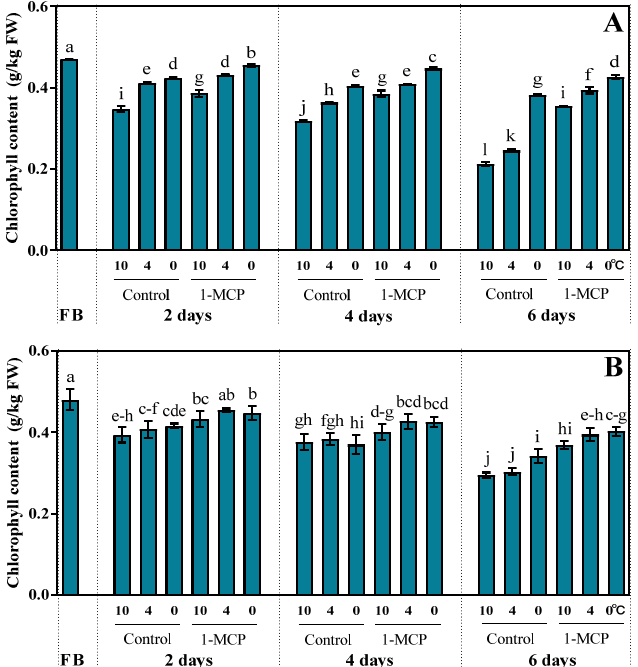
Figure 1. Effects of storage temperature and 1-MCP treatment on chlorophyll content in broccoli florets. ( A ) Yanxiu, ( B ) Xianglv No.3. Storage temperature: 10, 4, and 0 °C; control: without 1-MCP treatment; 1-MCP: 1-MCP treatment; FB: the fresh broccoli florets; storage time: 2, 4, and 6 days. Error bars represent SD from three replications of under every treatment under storage experiment. Different letters indicate statistically significant differences among treatments ( p < 0.05).